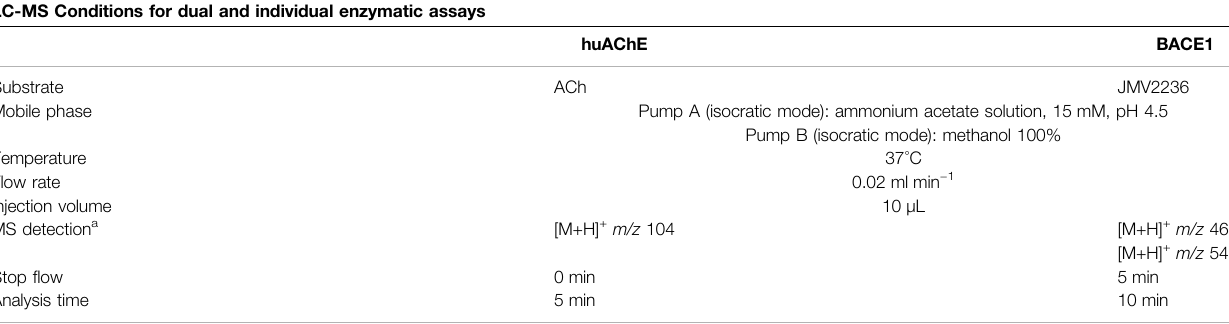
TABLE 1 | LC-MS conditions for measuring enzymatic activity in the huAChE+BACE1-ICER-LC-MS system. LC-MS Conditions for dual and individual enzymatic assays